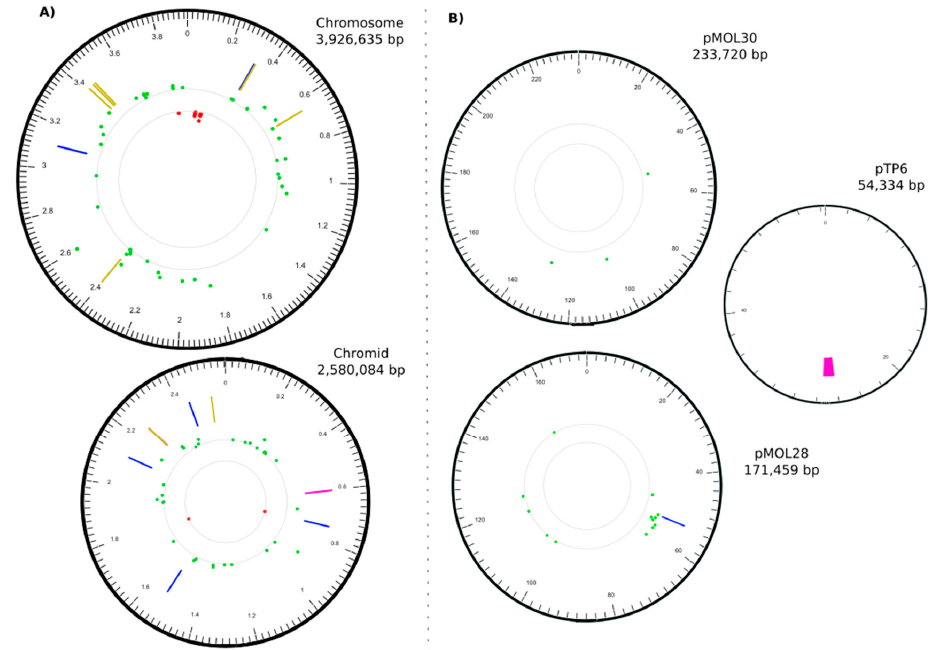
# Chromosome: CHR1 ; chromid: CHR2 ; arrows show positive → or negative ← gene orientation;